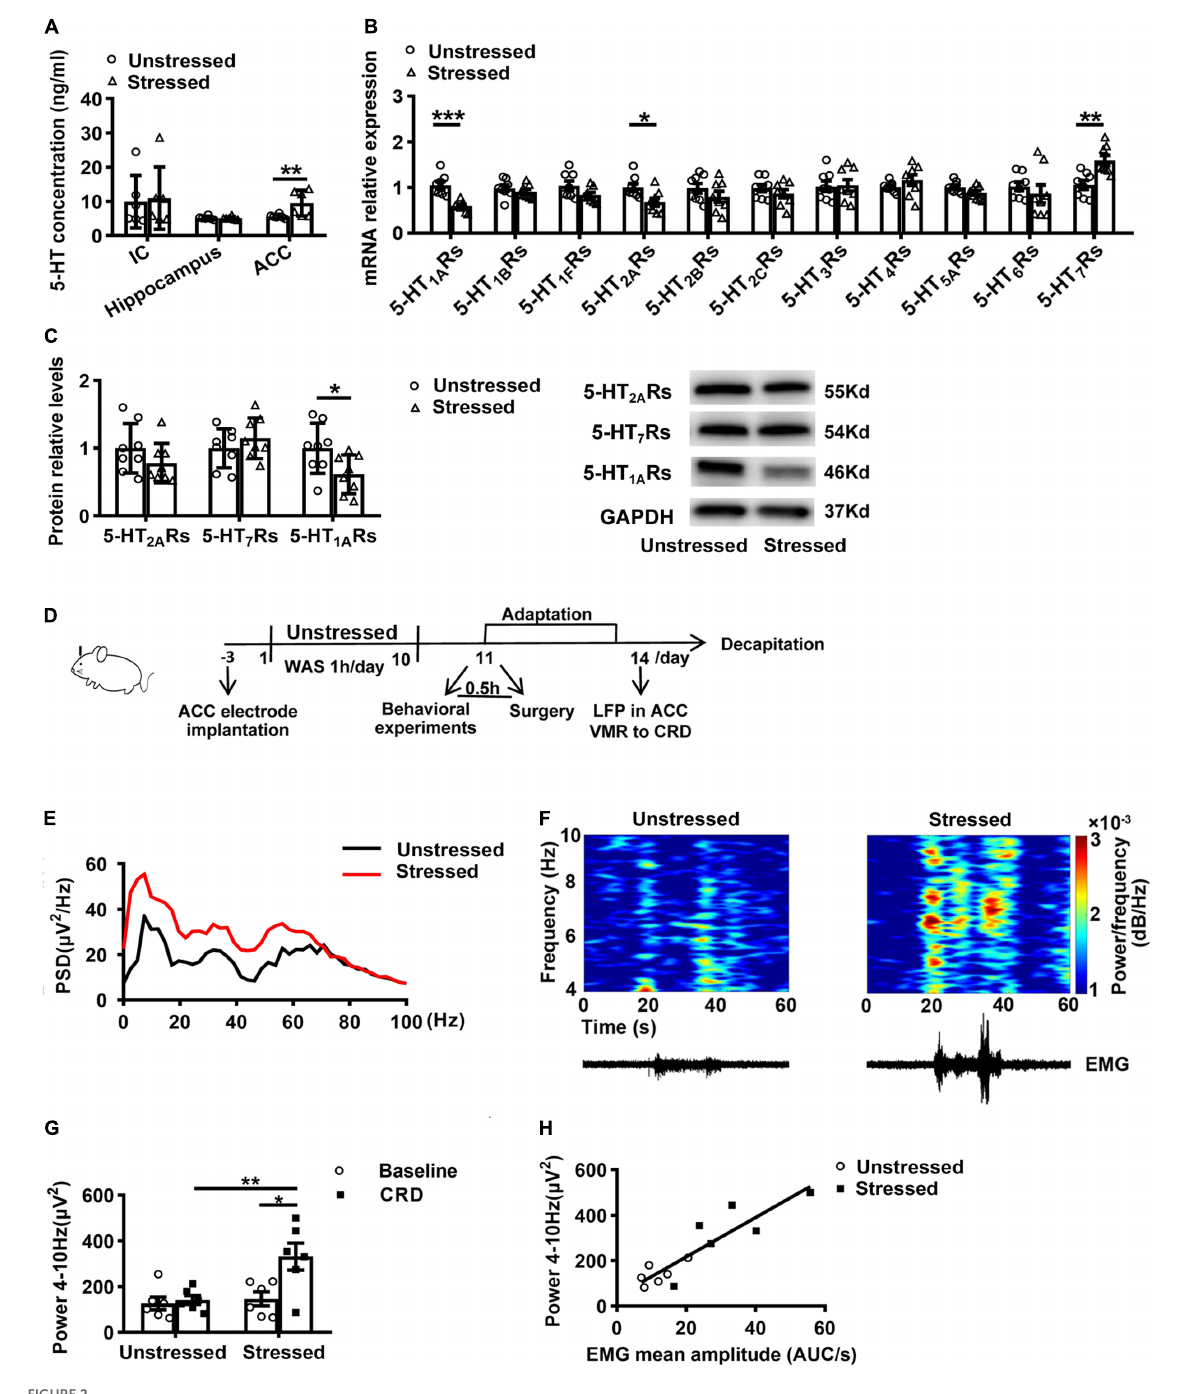
FIGURE2 Stress increased 5-HT concentration, reduced 5-HT 1A Rs expression, and enhanced theta band (4–10 Hz) power in ACC. (A) 5-HT concentration in the insular cortex (IC), hippocampus, and anterior cingulate cortex (ACC) ( n = 6 for Unstressed and Stressed respectively). (B) mRNA expression of serotonin receptor gene in ACC ( n = 8 for Unstressed and Stressed, respectively). (C) Western blot analysis of the serotonin receptor protein in ACC ( n = 8 for Unstressed and Stressed respectively). Stress enhanced theta band power in ACC in vivo ( n = 6 for Unstressed and Stressed, respectively). (D) Experimental design. (E) Mean power spectral density (PSD) plots during 20s-CRD treatment in ACC of unstressed (black line) and stressed (red line) rats. (F) Time–frequency diagrams of the power of theta oscillations in ACC and corresponding EMG. (G) The integral power of theta oscillations during pre-CRD (Baseline) and 20s-CRD. (H) Correlation between theta oscillation power in ACC during 20s-CRD and the EMG of visceromotor response, based on combined data points obtained in the unstressed (circle) and stressed (square) rats, R 2 = 0.8019, p < 0.0001. * p < 0.05, ** p < 0.01, *** p < 0.001. Data are presented as means ±